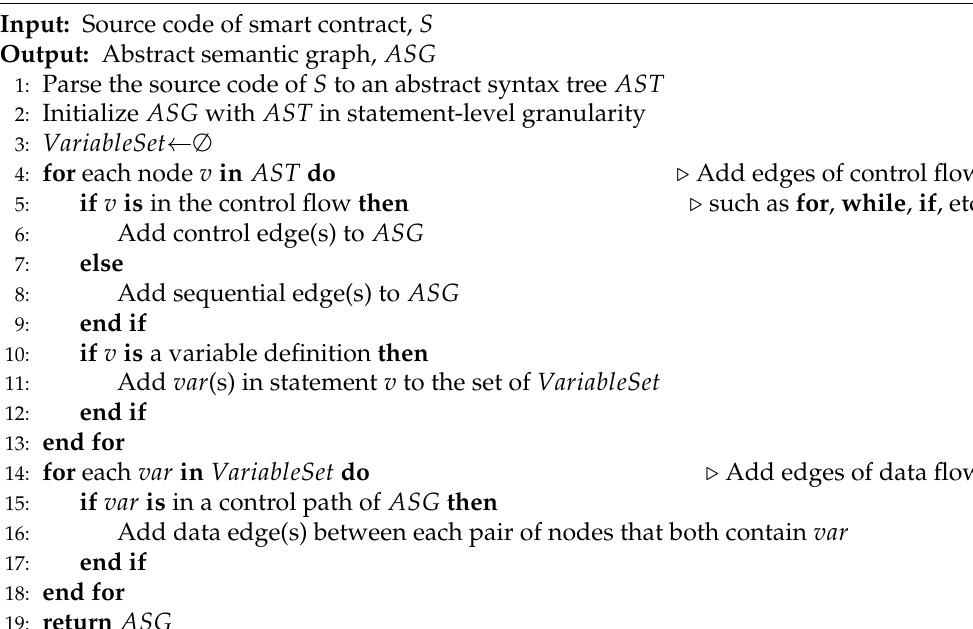
Algorithm 1 ASG generation from source